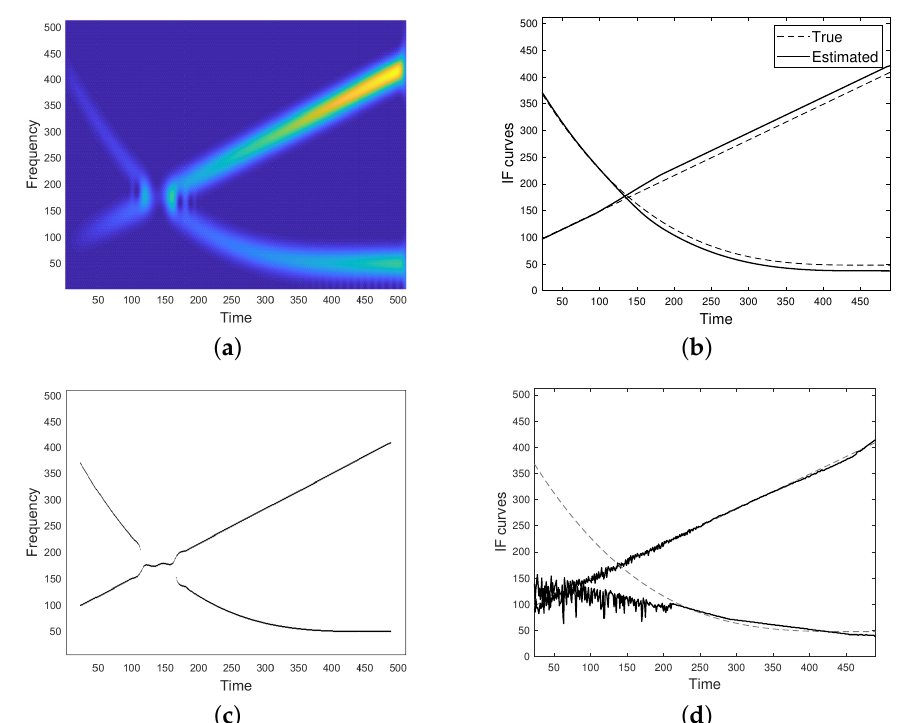
Figure 9. ( a ) Spectrogram of the AM-FM two-component signal as in Equation (28). ( b ) IF curves provided by the proposed method. ( c ) IF curves estimated from spectrogram maxima. ( d ) IF curves estimated by applying the Radon Spectrogram-based method in [27].